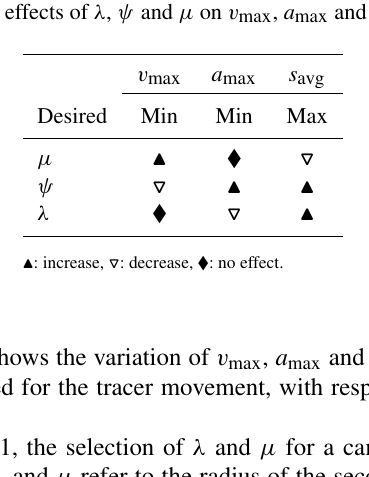
Table 1. The effects of λ , ψ and µ on v max , a max and s avg